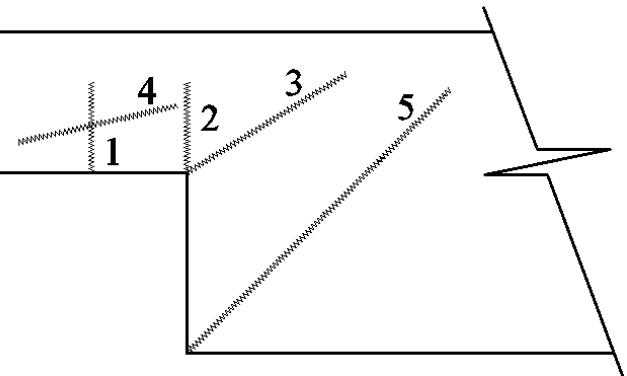
Figure 1. Failure modes of the dapped-end beams; digits 1, 2, 3, 4, and 5 refer to a nib flexure crack, a direct shear crack, a re-entrant corner crack, a nib inclined crack, and a diagonal tension crack, respectively.